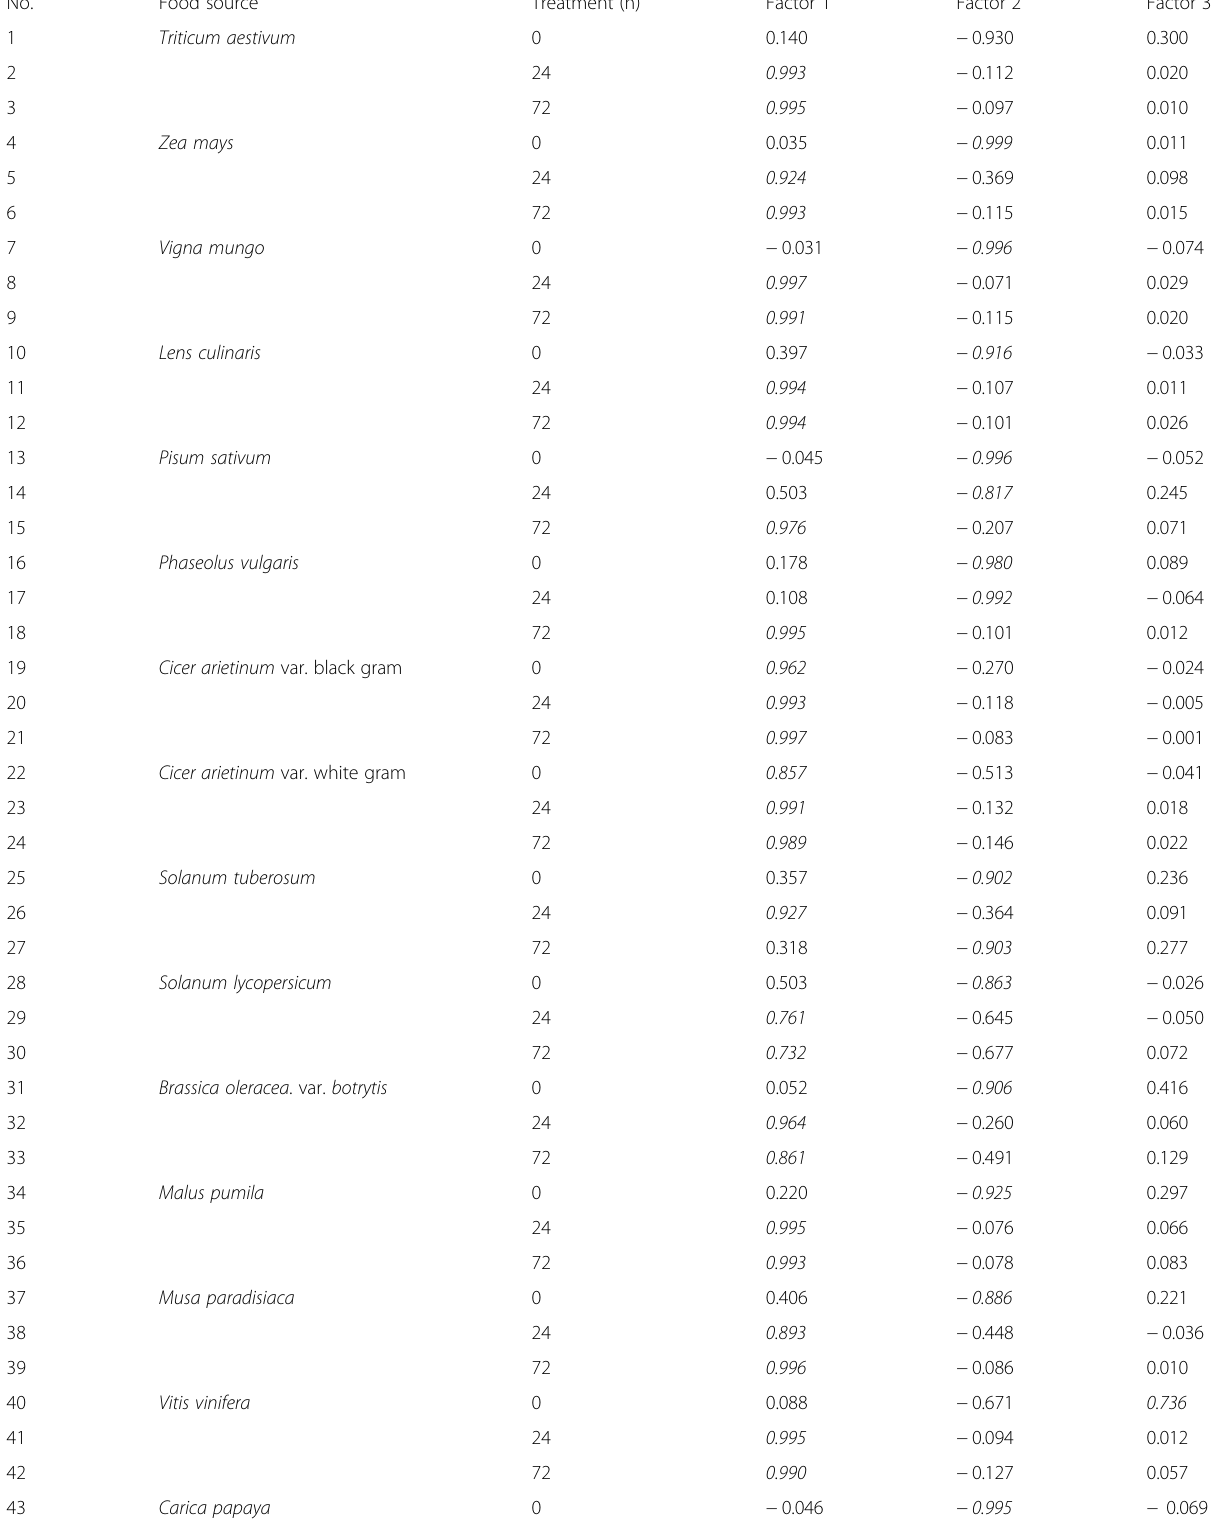
Table 2 CABFAC factor analysis of edible food plants and milk on the basis of organic acid contents for 0 h, 24 h, and 72 h under E. coli treatments. Values in italics represent significant